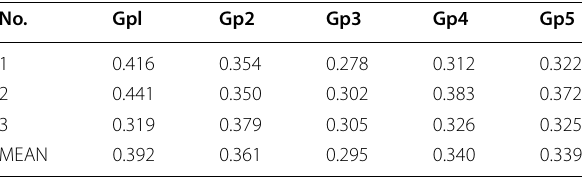
G3 ( L. Acidophillus , G4 L. casei , G5 L. lactis , Gl (positive control, L . Plantarum ), G2 (control, no bacteria)